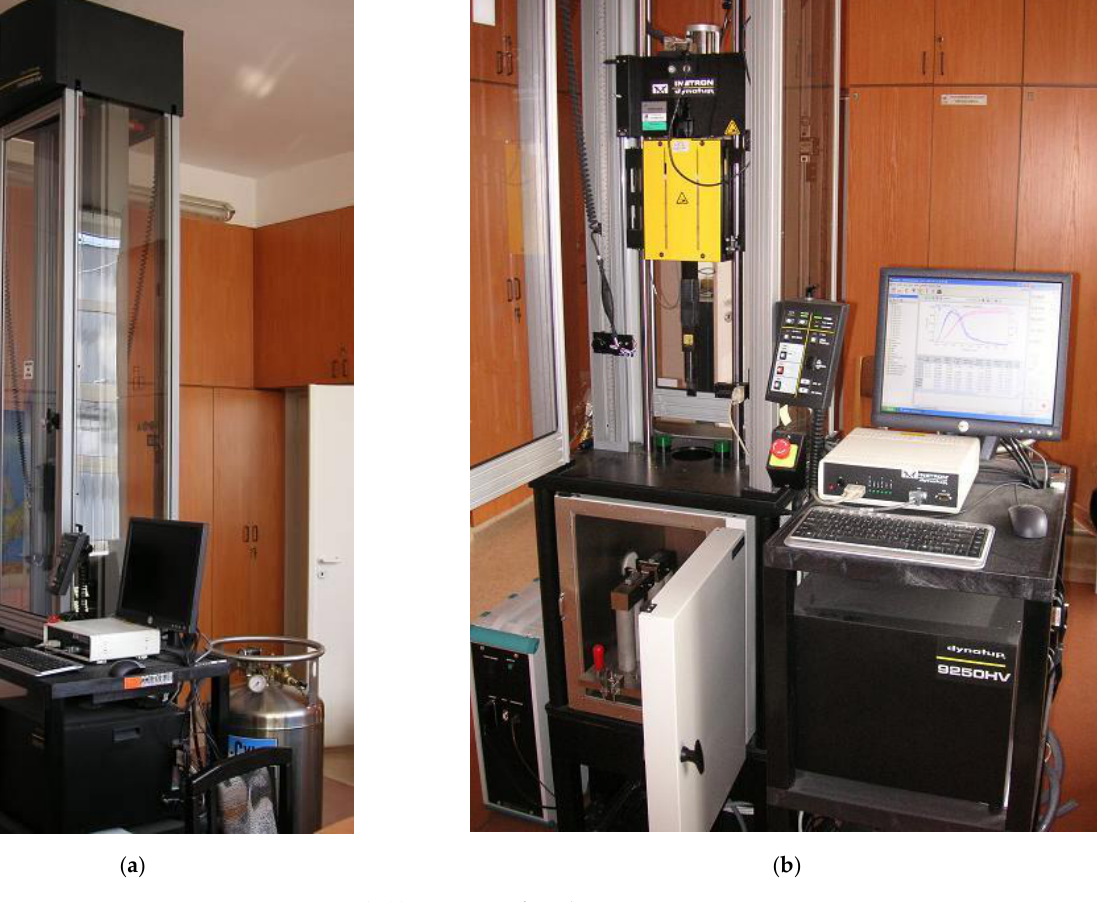
Figure 1. ( a , b ) Test setup for Charpy impact test. V-notch samples were prepared as specified in [35]. Detailed sample geometry is shown in Figure